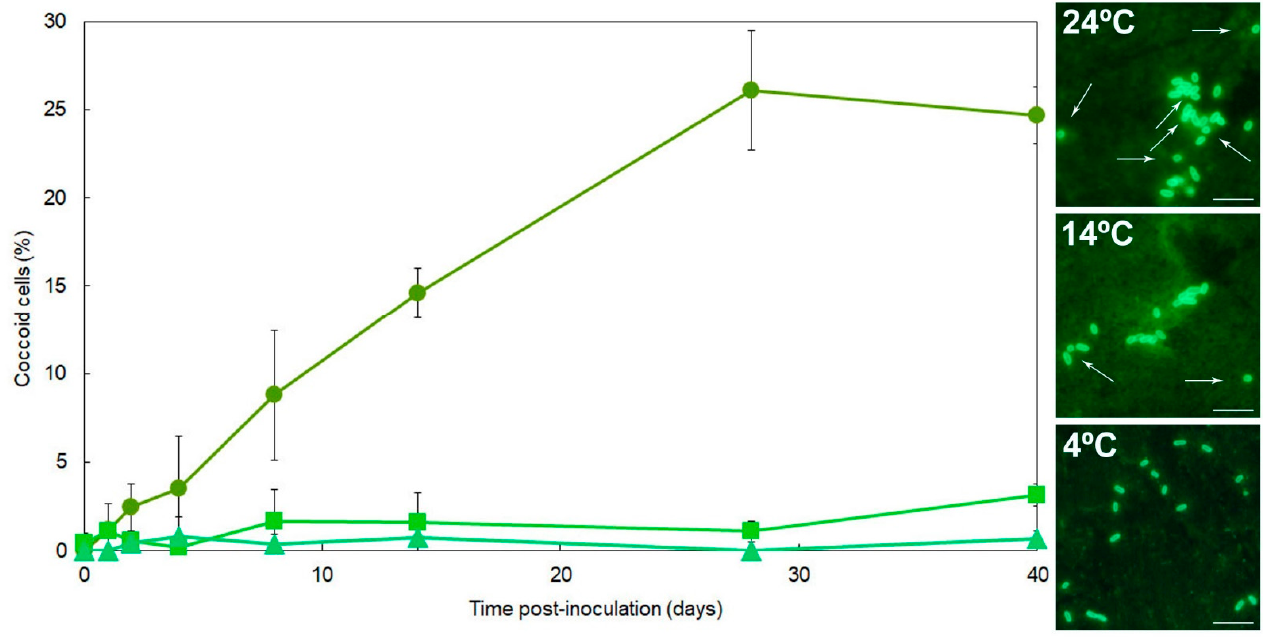
Figure 3. Proportions of coccoid cells appearing in Ralstonia solanacearum strain IVIA-1602.1 popu- lations starved in the environmental water microcosms during 40-day periods at 24 °C, 14 °C, and 4 °C. ( Left ) Symbols for each temperature: 24 °C ( ● ), 14 °C ( ■ ), and 4 °C ( ▲ ). Data from one representative environmental water sample have been plotted. Points are mean ± standard deviation of triplicate microcosms. ( Right ) Representative fluorescence microscopy images of proportions of coccoid cells (white arrows) of the bacterium at each temperature. Scale bars: 5 µm. At 4 °C and throughout the 40-day experiments, bacterial cells showed the typical R.